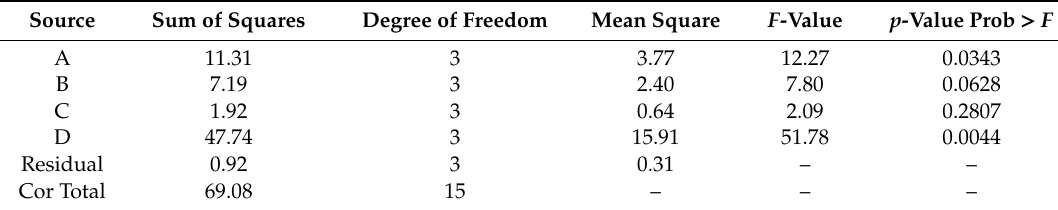
Table 8. ANOVA on S / N of GRG.